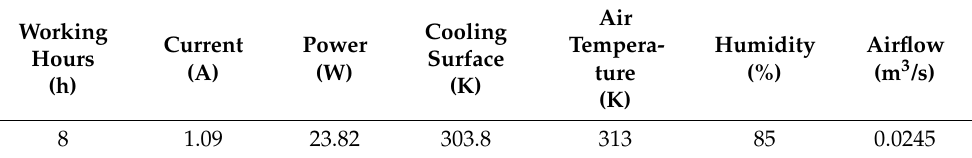
Table 1. Input parameters for experiment performed in climate chamber.